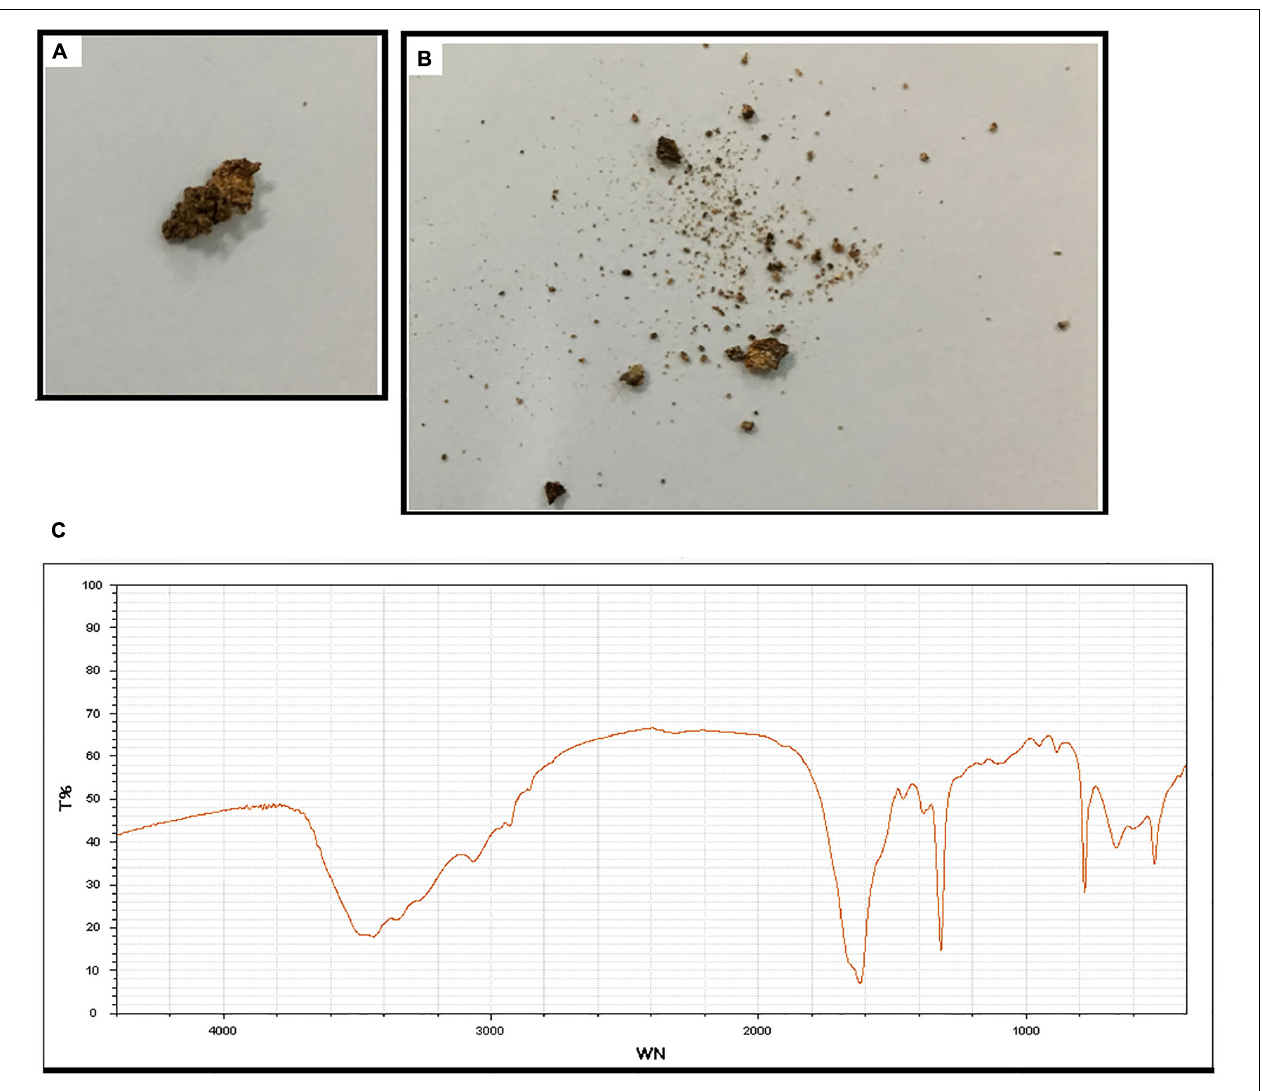
FIGURE 4 | Composition analysis of the renal calcareous sediments. (A,B) Renal tissue (5 g) dried at high temperature (180 ◦ C) for 2 h. (C) Infrared spectroscopy of the sediments revealed the crystal as calcium oxalate monohydrate. An automatic infrared spectrum analysis system, LIIR-20 (approved by the Chinese FDA,